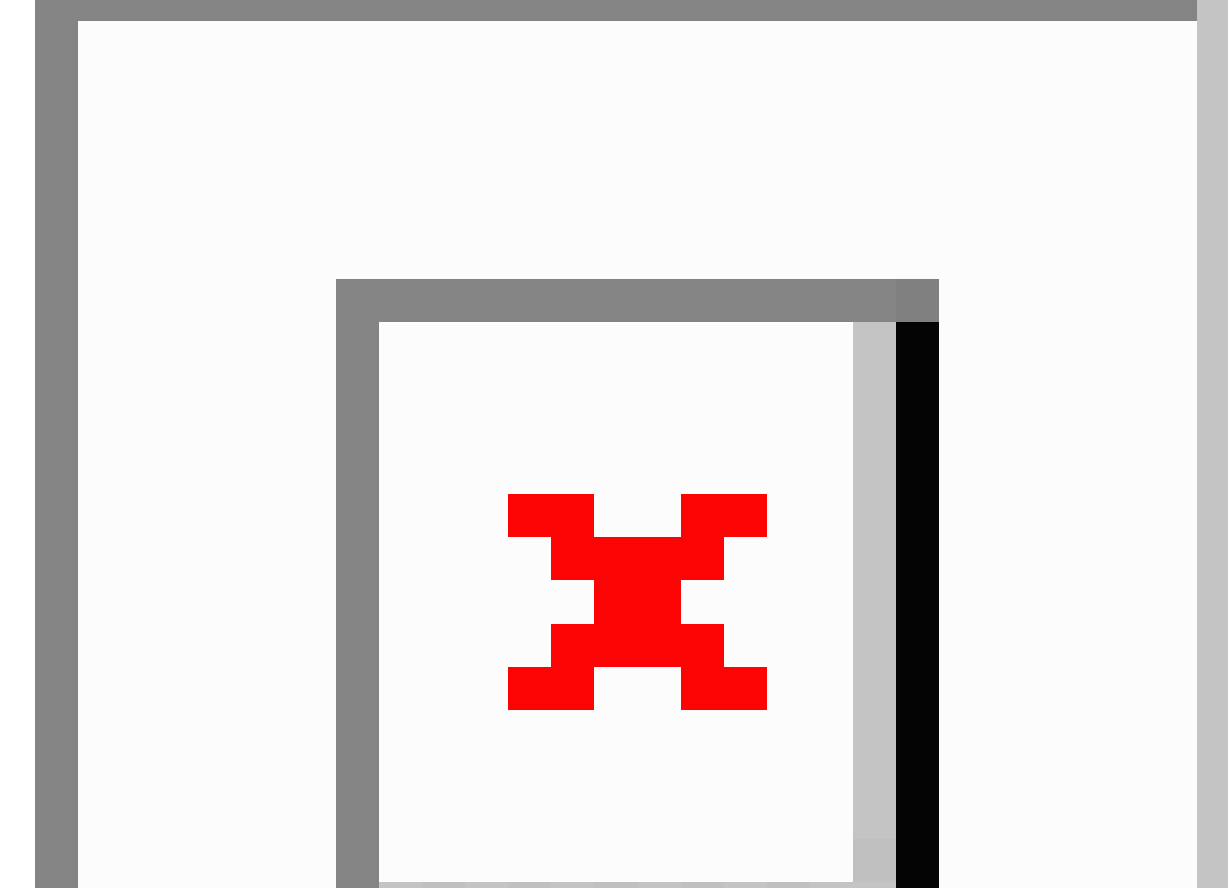
Figure 12. Statistical differences in the different score intervals for objective scores in the final written pathology examination results. *: statistical significance; ns: no statistically significant